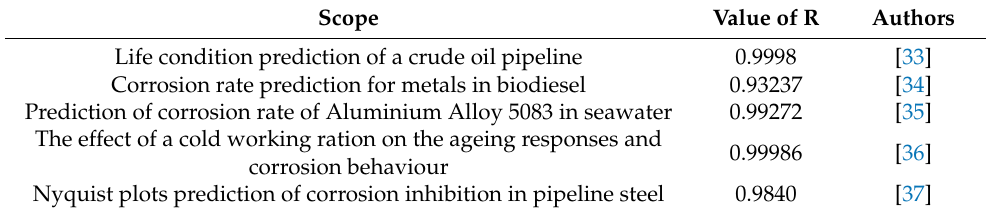
Table 3. Past research employed the Levenberg–Marquardt model as a training algorithm in their prediction